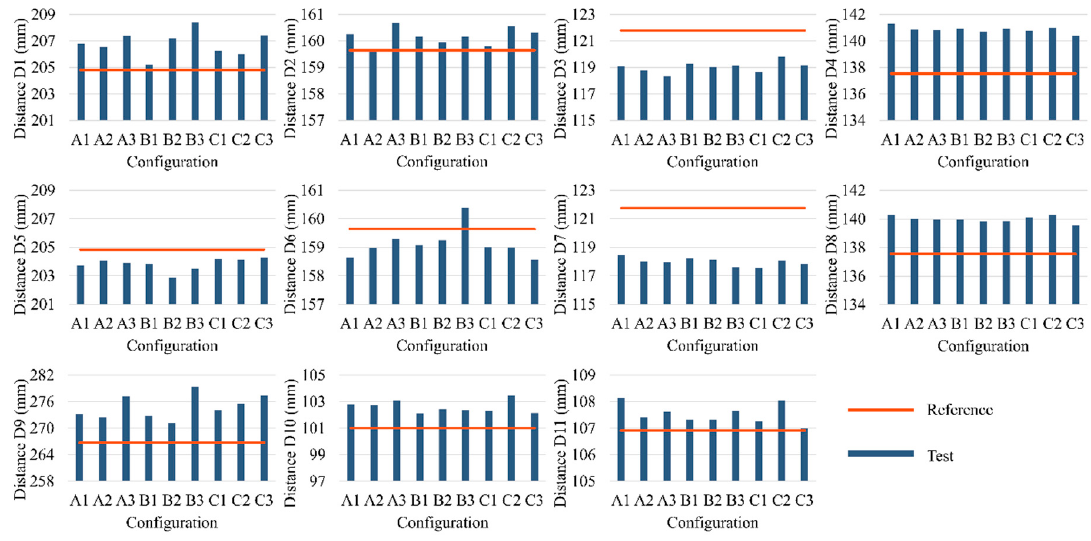
Figure 9. Feature distance results.